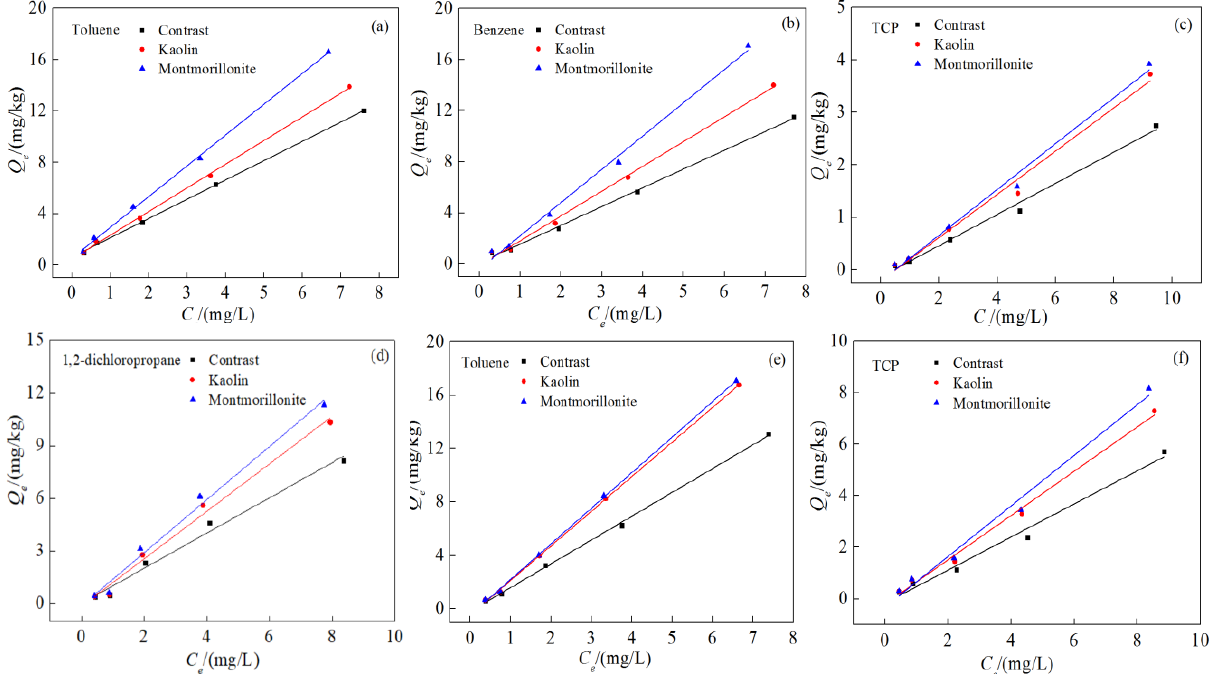
Figure 8. The effect of clay minerals on the competitive adsorption of ( a , b ) toluene and benzene, ( c , d ) TCP and 1,2−dichloropropane, and ( e , f ) toluene and TCP in different two−component systems. ( c , d ) TCP and 1,2 − dichloropropane, and ( e , f ) toluene and TCP in different two − component systems. (The amount of clay minerals added was 10%.) (The amount of clay minerals added was